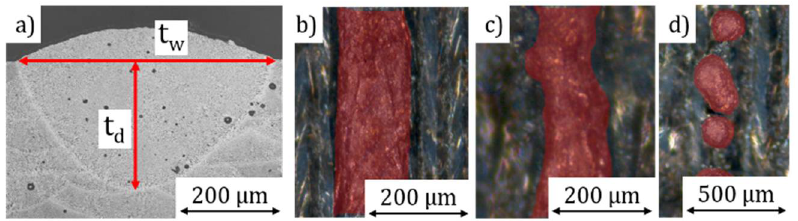
Figure 4. Analysis of the melt tracks produced with different LED: ( a ) microsection measurement, ( b ) stable, ( c ) humping, and ( d ) balling weld track.